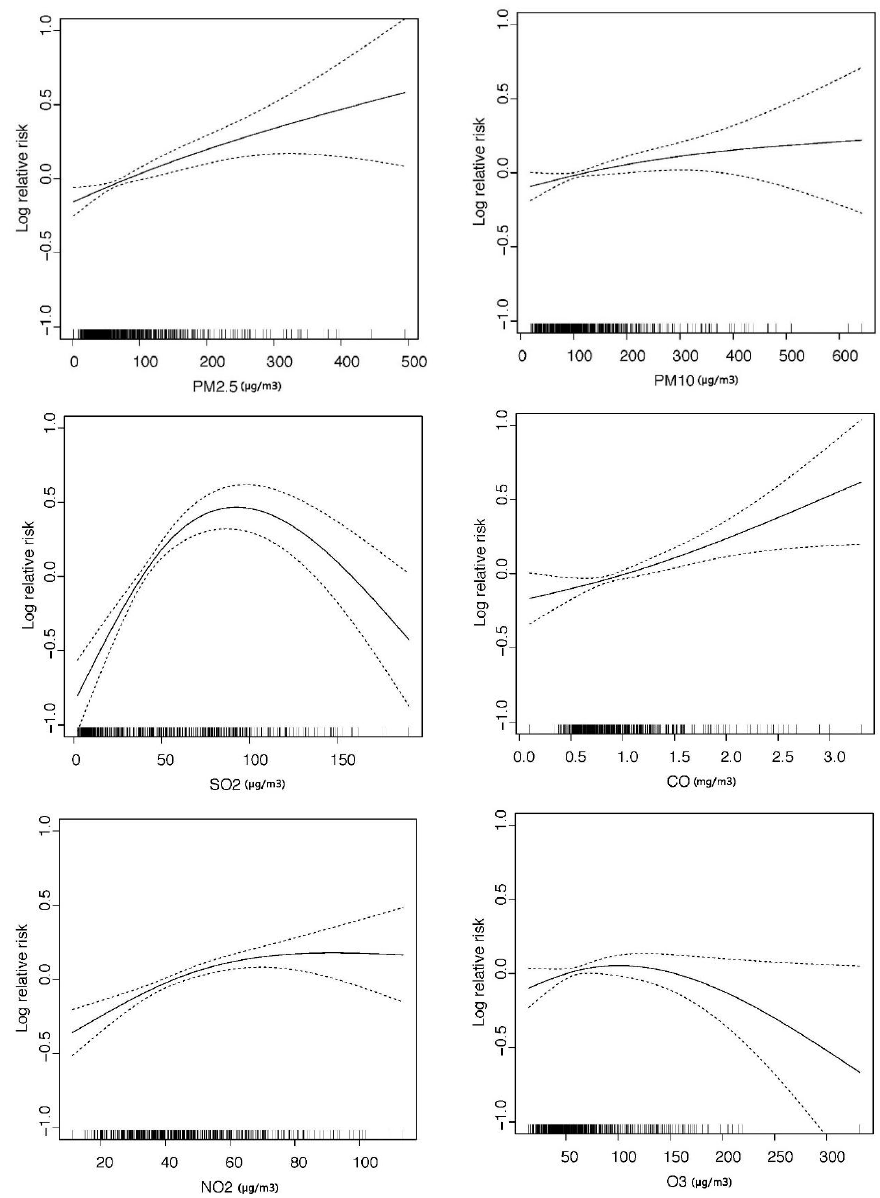
Figure 3. Smoothed plots of exposure-response relations between air pollutants (current day) and outpatient visits for AR in Changchun, China (2012–2015). The solid line presents log relative risk of outpatient visits for AR, while the dashed lines present 95% confidence interval (CI) of the log relative risk.